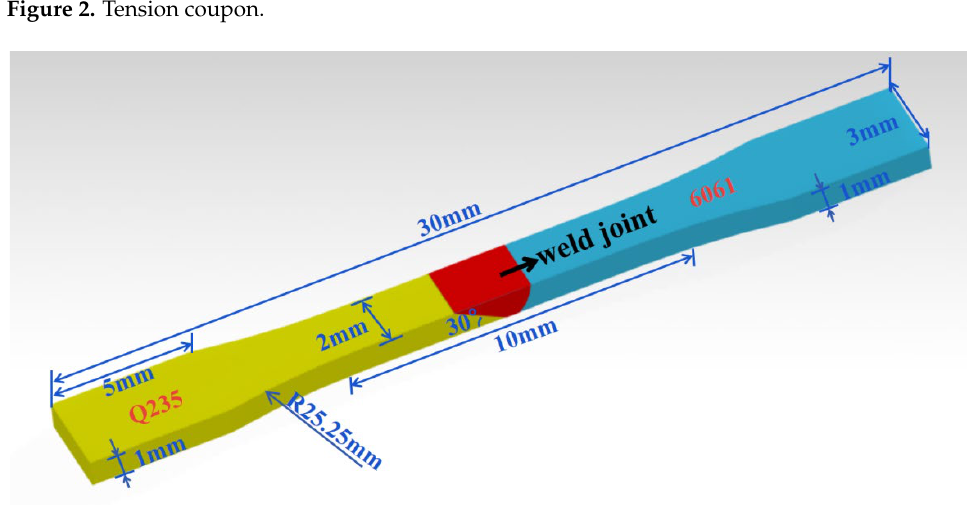
Figure 3. Fatigue coupon.